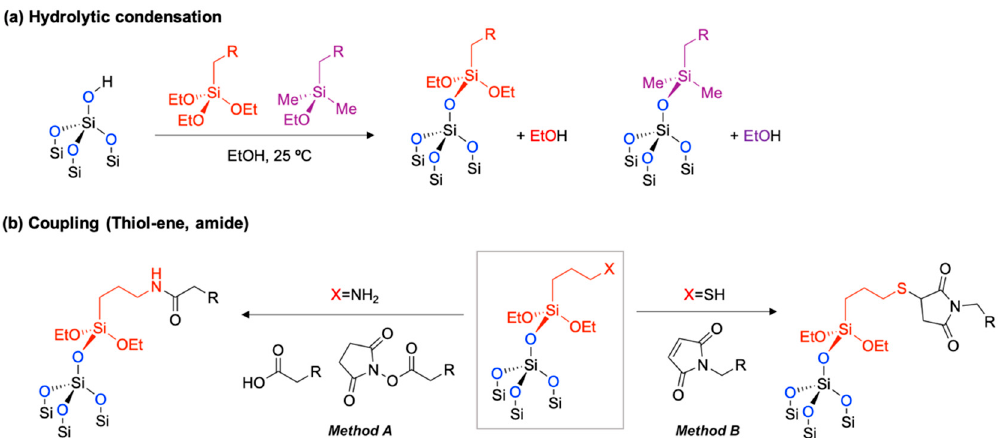
Figure 4. Surface modification of oxidized pSi. ( a ) Hydrolytic condensation with silanol reagents. ( b ) Further functionalization of hydrolytic condensation products via amide coupling (Method A) and thiol-ene addition (Method B). A box in Figure ( b ) indicates the surface functionality of hydrolytic condensation with APTES or MPTES on the oxidized pSi.